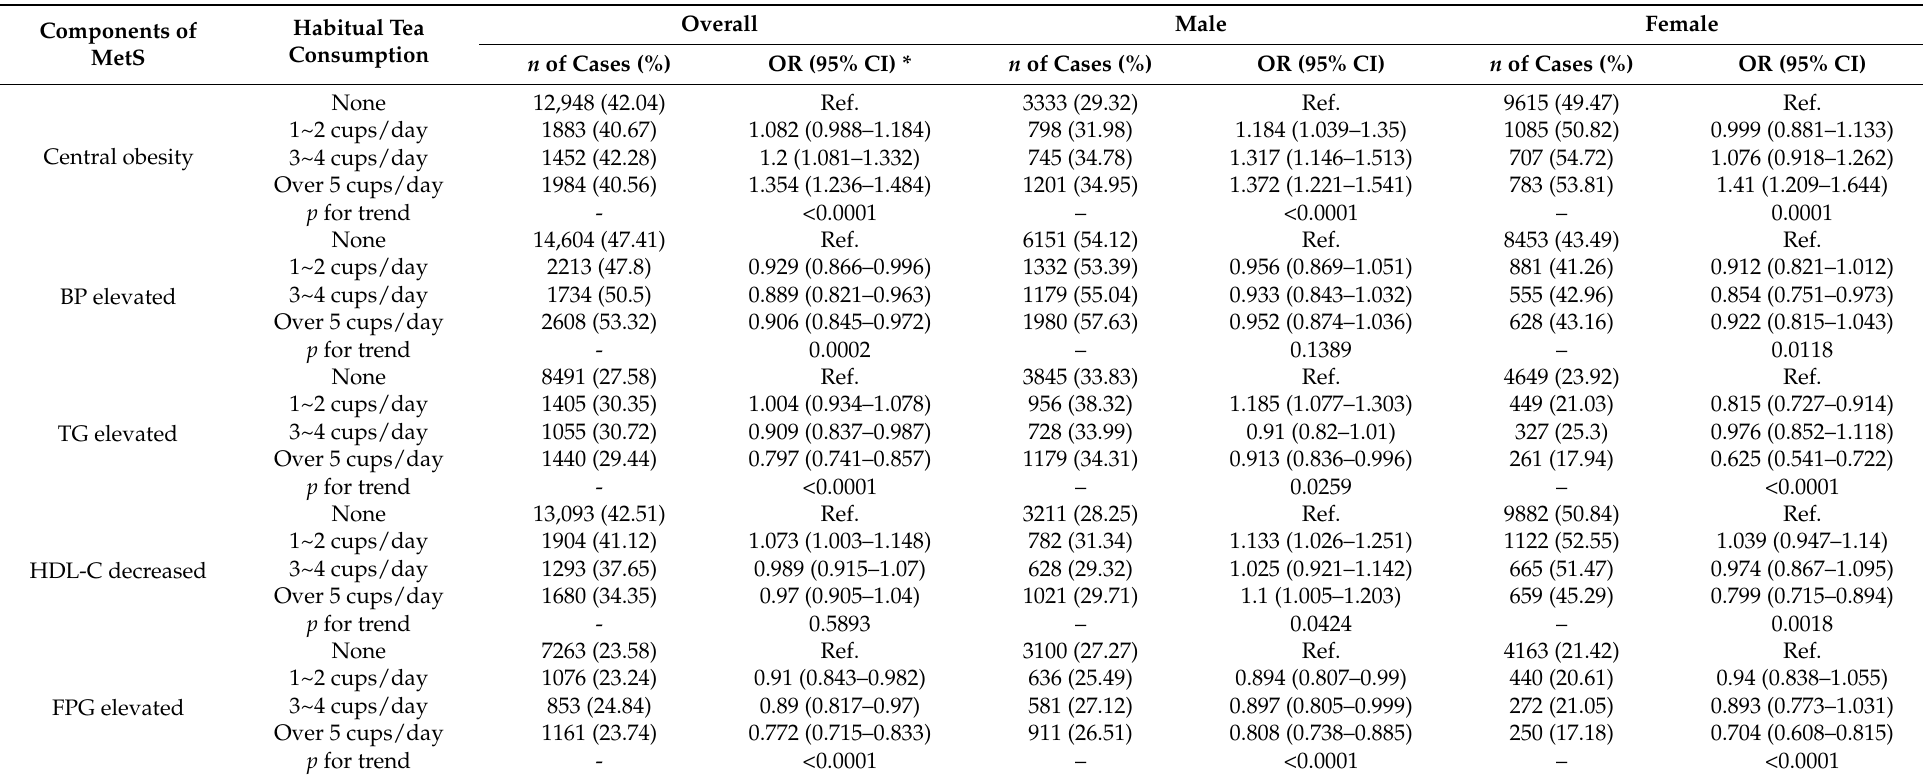
Table 4. Association between different components of MetS and habitual tea consumption among overall, male, and female